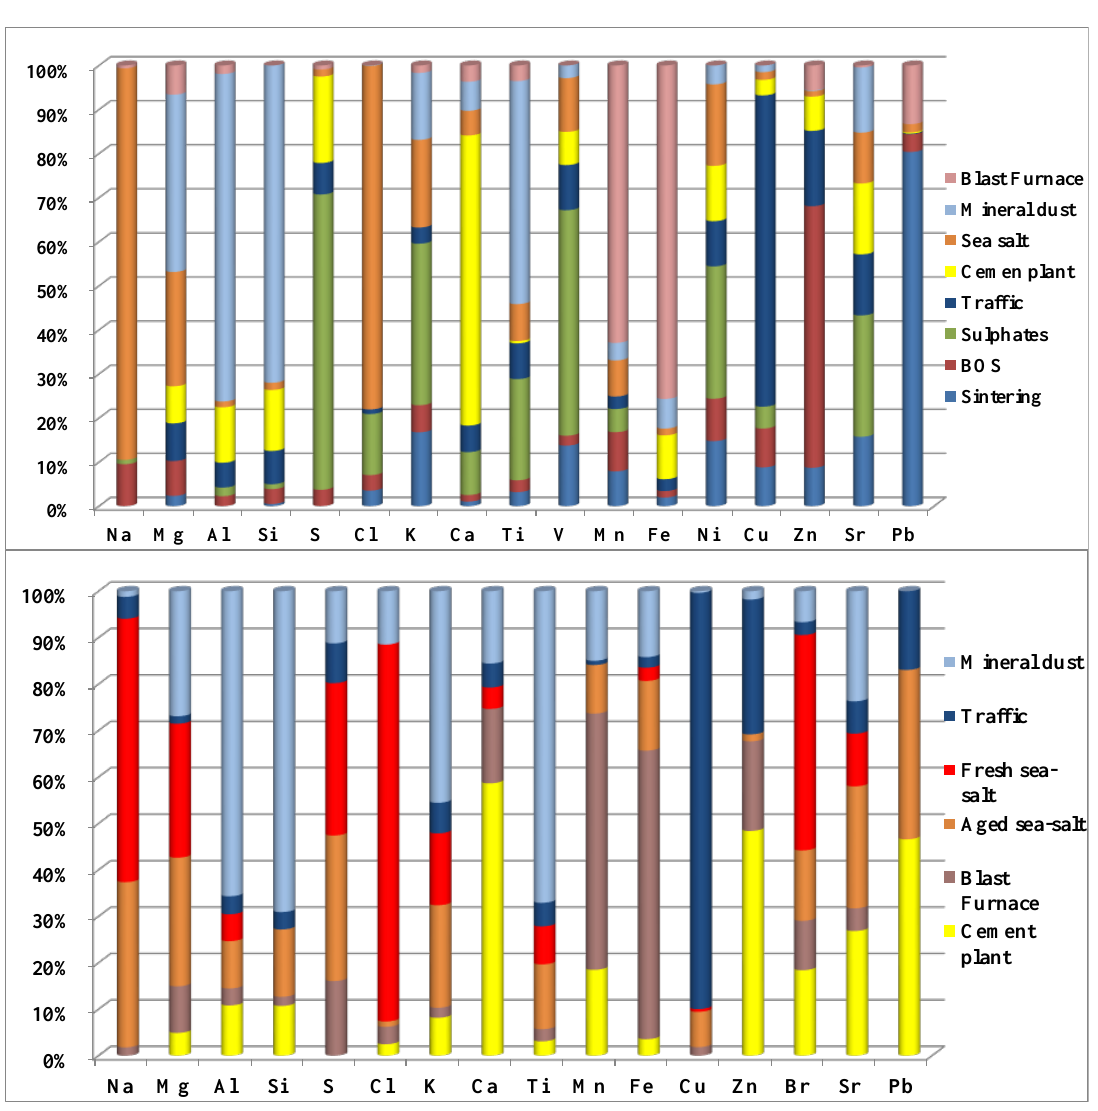
Figure 10. Distribution of the chemical species between the sources identified by PMF in the fine fraction (above) and in the coarse one (below).